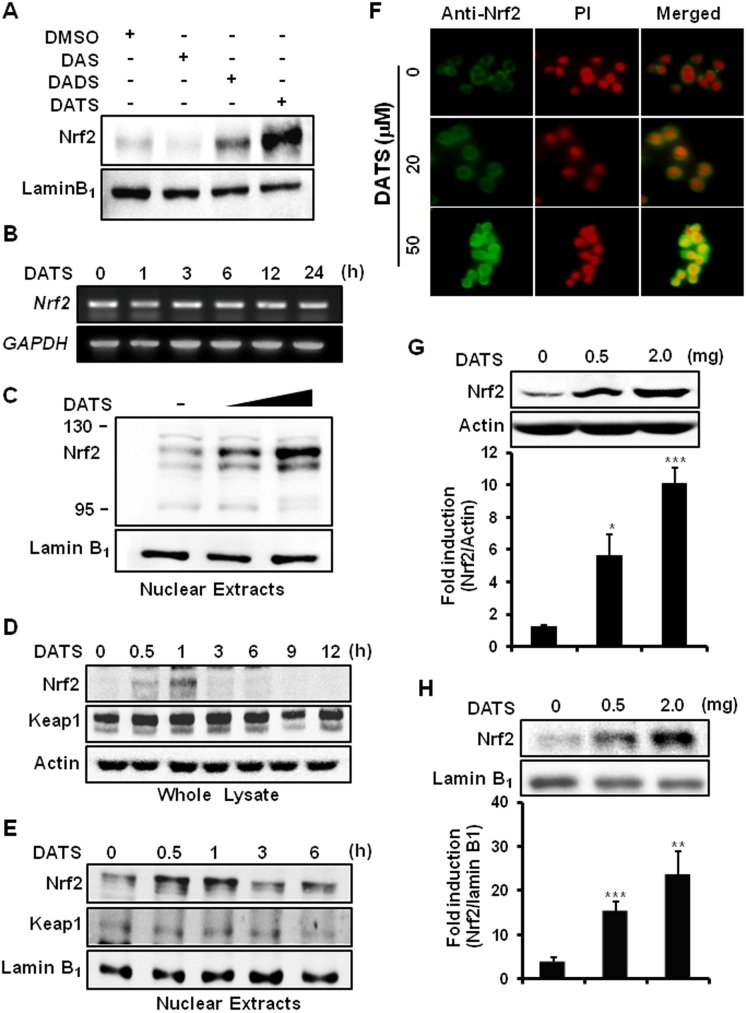
DATS induces the nuclear accumulation of Nrf2 in vitro and in vivo.(A) AGS cells were treated with DAS, DADS, and DATS (20 µM of each). After 1 h, the cells were harvested, and fractionated to prepare the cytosolic and nuclear extracts. The nuclear level of Nrf2 was determined by Western blot analysis. Lamin B1 was used to ensure the purity and equal loading of nuclear protein. (B) AGS cells treated with or without DATS (20 µM) were harvested at the indicated intervals, and total RNA was prepared. The RNA samples were analyzed by RT-PCR for detecting the levels of Nrf2 mRNA, as described in Metarials and Methods. GAPDH was used as a control for equal loading. (C) Nuclear extracts prepared from cells treated with DATS (5 or 20 µM) were subjected to Western blot analysis for detecting the nuclear localization of Nrf2. (D) Cells, treated with DATS (20 µM) for the indicated time periods, were lysed and the protein expression of Nrf2 and Keap1 in the whole cell lysate was determined by Western blot analysis. (E) Upon incubation with DATS (20 µM) for the indicated time, nuclear extract was prepared and immunoblotted to determine the nuclear localization of Nrf2 and Keap1. (F) AGS cells were treated with DATS (5 or 20 µM) for 1 h. The immunofluorescence staining of Nrf2 was conducted as described in Metarials and Methods. (G–H) Data are represented as fold induction of Nrf2 expression against control. Error bars represent SEM. Columns, means (n = 3); *, **, and *** Significantly different from that of control (p<0.05, 0.01, and 0.001, respectively) (G) The expression of Nrf2 from whole lysate of mouse gastric tissue prepared as described for Fig. 1D was assessed by Western blot analysis. (H) The gastric tissues of mice treated with DATS or vehicle were fractionated, and nuclear localization of Nrf2 was determined by Western blot analysis.